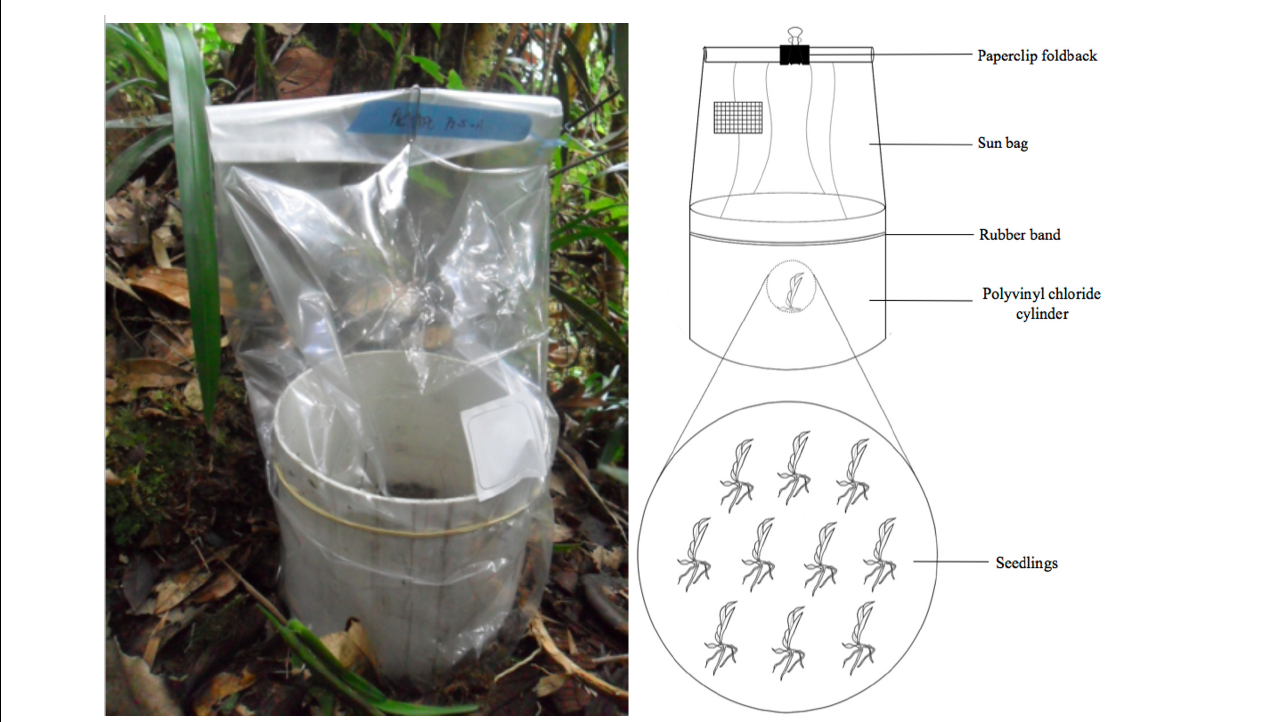
FIGURE 1 | Photo and schematic illustration of the seedling-trap systems. Seedling-traps included polyvinyl chloride cylinder, 10 seedlings, covered with a sun bag adjusted with a rubber band and a paperclip foldback.